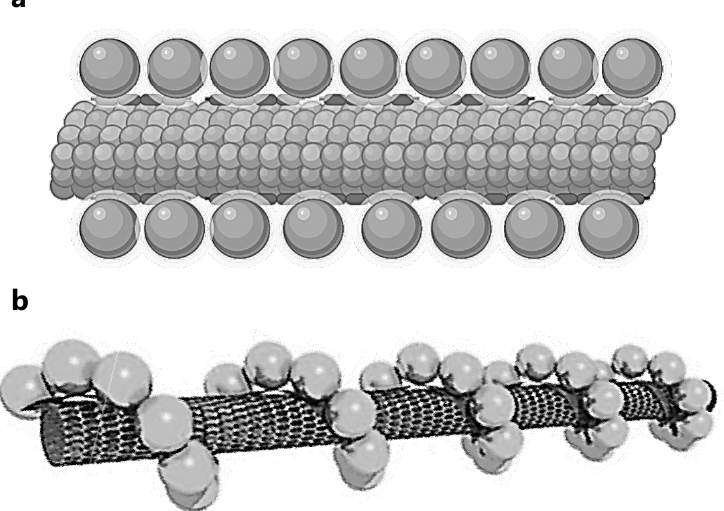
Figure 7. Proposed models for the possible alignment of porphyrin polymer molecules (marked with AuNPs) on SWNT surface: ( a ) porphyrin molecules (marked with AuNPs) may form a coplanar, well-ordered, regular, repeated array, and ( b ) porphyrin molecules (marked with AuNPs) may wrap along the tube surface, forming a helical structure. Figure 8 depicts the typical HR-TEM images of porphyrin polymer molecules (marked with AuNPs) on a SWNT surface. It is obviously shown from the images that the porphyrin polymer molecules self-assemble in the form of a coplanar, well-ordered, reg- ular, repeated arrays (Figure 7a) rather than wrapping along the tube surface. The self- assembly process restricts the porphyrin rotation about the butadiyne links, which in- creases the coplanarity between neighboring porphyrins along the polymer chain. Addi- tionally, the nanotube acts as a template that restricts torsional disorder within the poly- mer backbone and induces a coplanar arrangement of porphyrin repeated units, which totally agrees with the previous assumption [40]. It was previously assumed that the pol- ymer molecules could align in the form of a coplanar, well-ordered, regular, repeated ar- ray on the tube surface, but unfortunately, with no clear experimental evidence [40], in this study, we succeeded in presenting some experimental proofs for that finding, i.e., HR- TEM as well as AFM measurements.